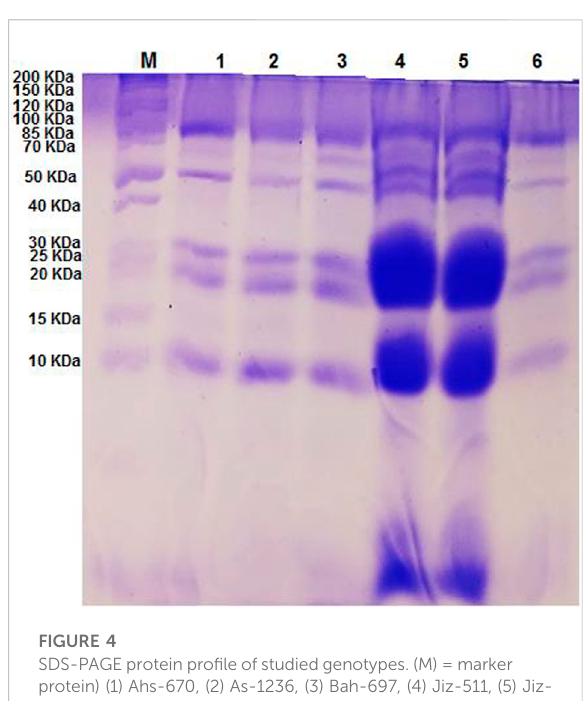
FIGURE 4 SDS-PAGE protein pro fi le of studied genotypes. (M) =